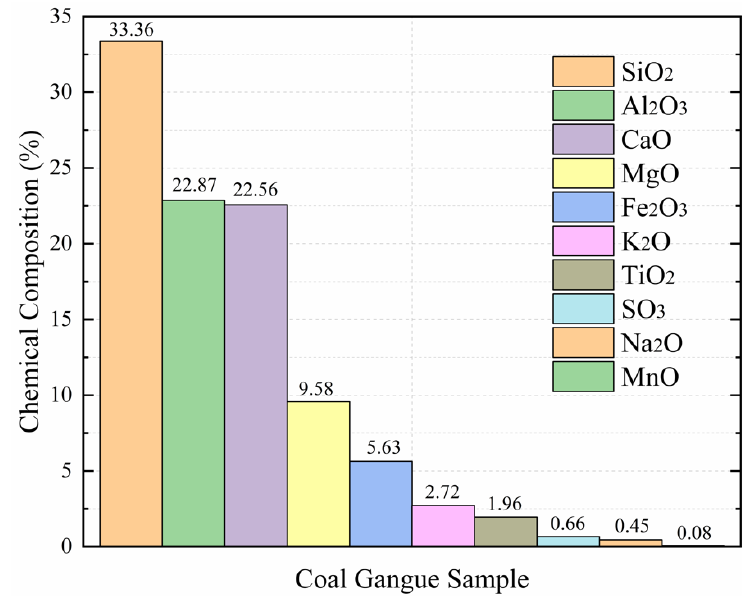
Figure 3. The chemical composition in the original coal gangue sample.